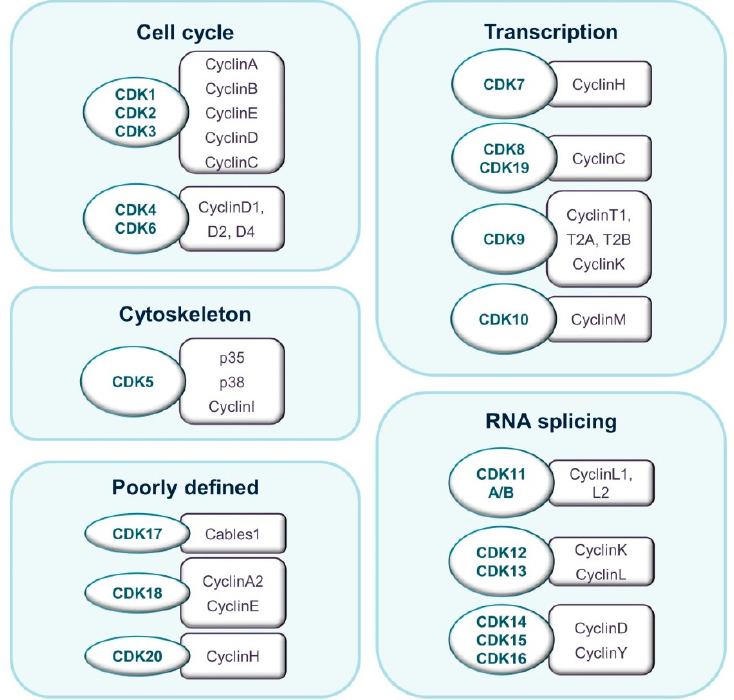
Figure 1. Classification of CDKs and their binding partners according to their prevalent described biological function.